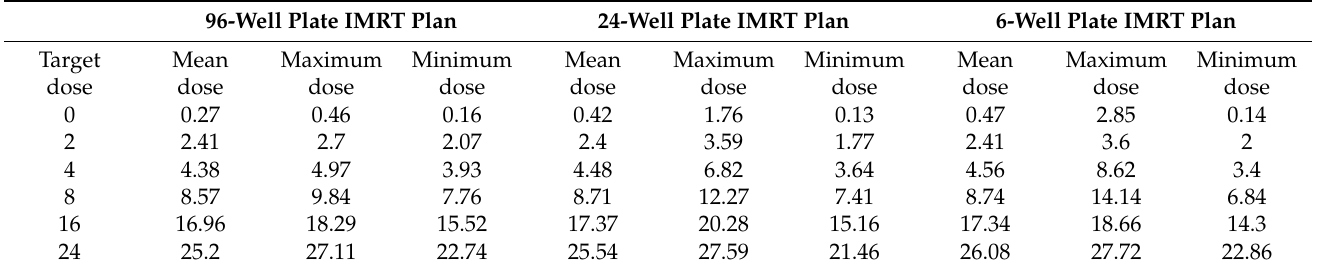
Table 1. Radiation dose statistics of multiwell tissue culture plate IMRT plans (radiation doses in